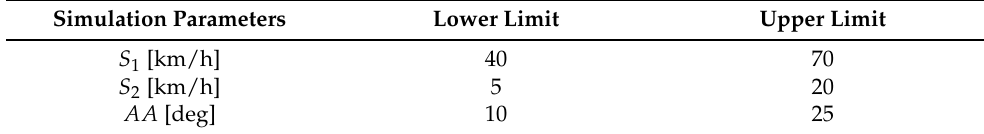
Table 3. Input parameters for the traffic jam approach scenario and their